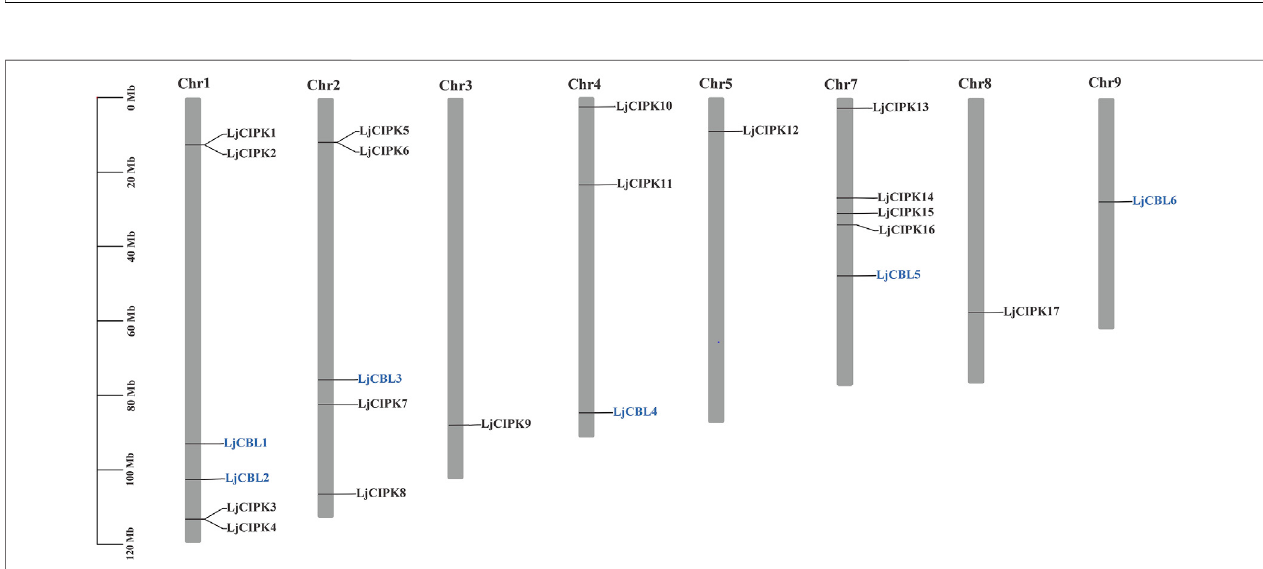
FIGURE2| PhysicalmappingofhoneysuckleCBL-CIPKgenes.ThenumbersofCBL-CIPKgenesareindicatedontherightofeachchromosome.Thescaleonthe left represents chromosome length.